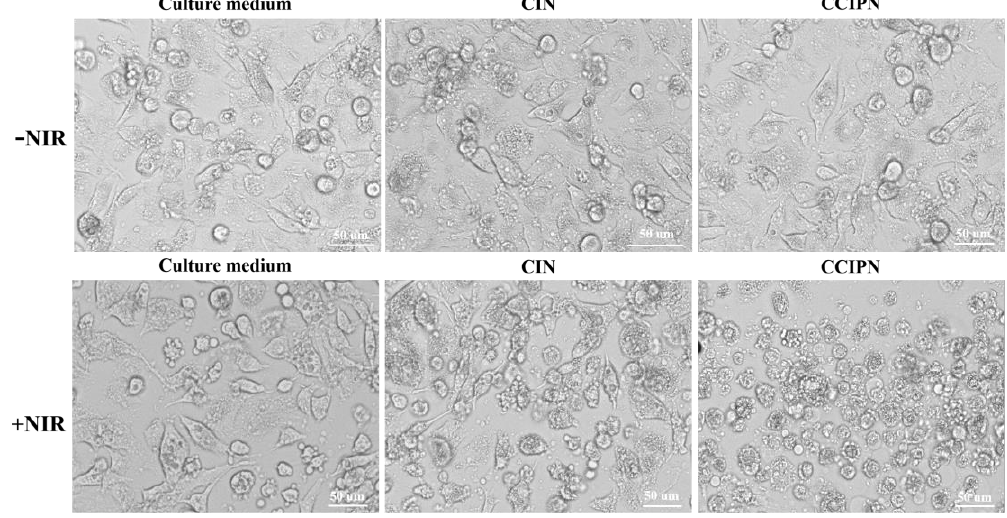
Figure 11. DU145 cell morphologies under different treatment conditions.